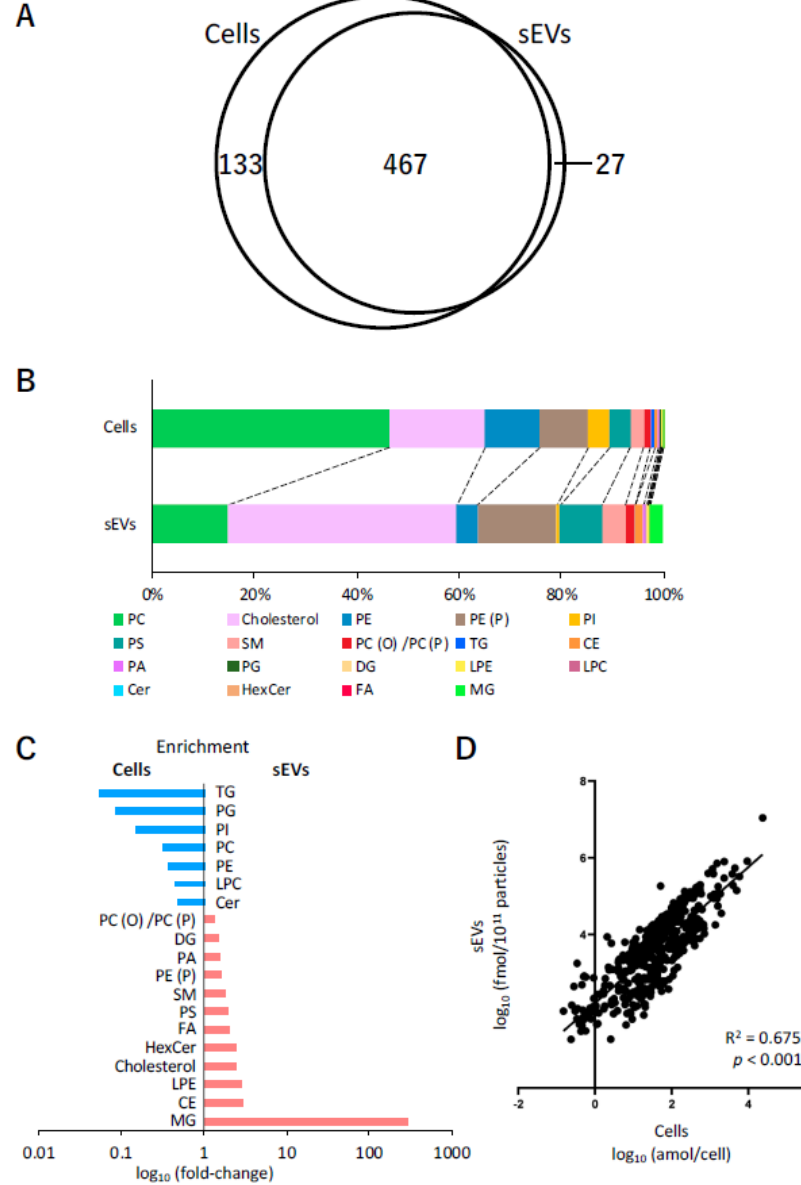
Figure 4. Lipidomic profiles of cells and small extracellular vesicles (sEVs) under normoxia. ( A ) Venn- diagram representing the number of lipids detected in cell and sEV samples. ( B ) Pie plots showing the mol-based percentile of each lipid class in cells and sEVs. ( C ) Enrichment of lipid classes in cells or sEVs. The data are shown as fold-changes of the ratio of lipid contents in sEVs per those of cells. ( D ) Correlation of the lipids in cells and